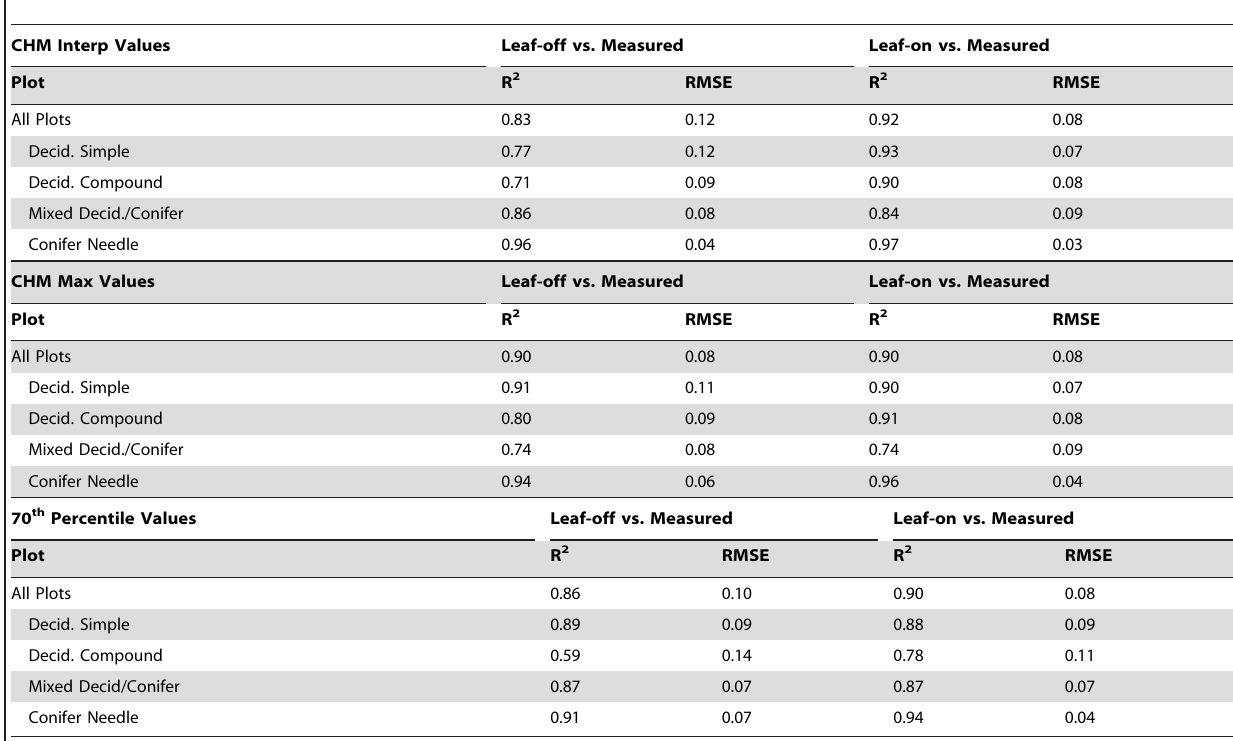
Table 5. Regression relationships interpolated lidar CHM (CHM interp ) vs. H, non-interpolated lidar CHM (CHMMax) vs. H and h70 vs. H for all plots and for plots stratified by leaf structure type.